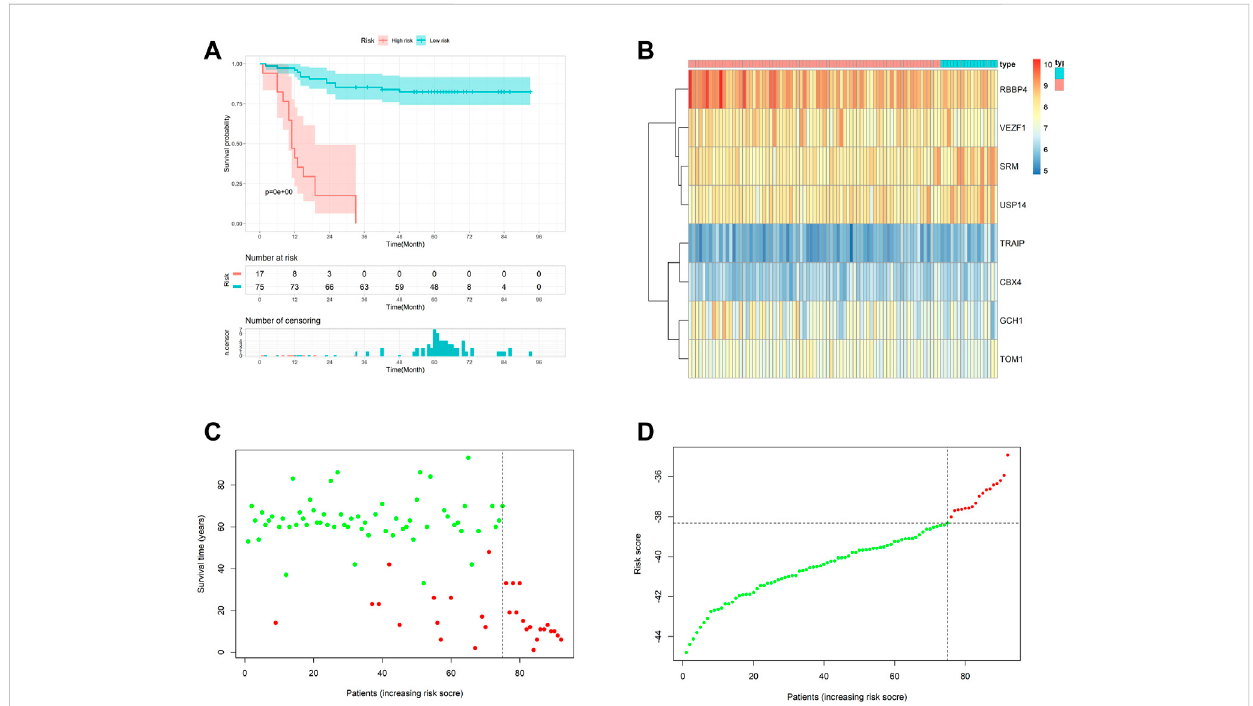
FIGURE 3 Internalvalidationoftheprognosticmodel. (A) Kaplan – Meiercurveswithlog-ranktestinthemetadata. (B) Heatmapofthehubgenesbetweenlow- and high-risk groups in the metadata. (C and D) Risk scores distribution of the metadata.